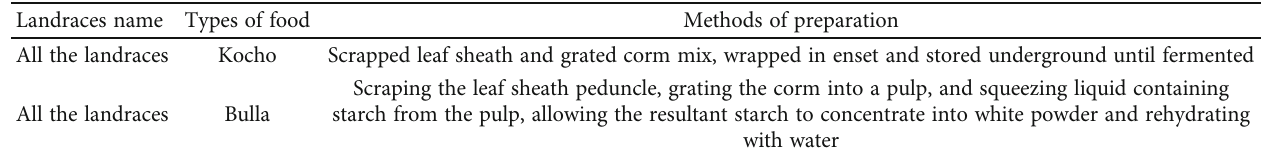
Table 7: Eating habits and food preparation methods for enset.